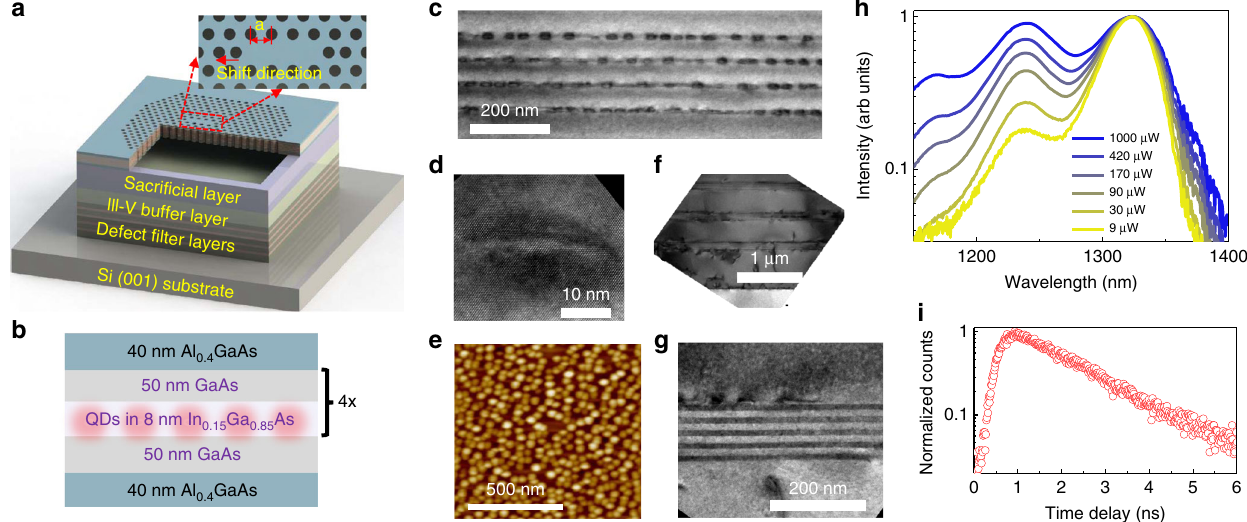
Fig. 1 Epitaxial growth, structural and optical characterisation. a Schematic diagram of the fabricated InAs/GaAs QD PC ( L 3 cavity) laser epitaxially grown on on-axis Si (001) substrate. The lattice constant, radius and shift of L 3 PC cavity are a , r and 0.15 a , respectively. b Schematic epitaxial structure of active region for the PC laser. c and d show the high-resolution cross-sectional bright- fi eld STEM images of the four-stack InAs QD layers and a single QD, respectively. e demonstrates an AFM image of uncapped InAs/GaAs QDs grown on Si (001) substrate. f presents a bright- fi eld STEM image of the interface between defect fi lter layers and on-axis Si (001) substrate. g shows the high-resolution TEM image of a defect fi lter layers. h Logarithmic plot of the normalised collected PL spectra under various input power at room temperature. i Time resolved PL measurement of the as-grown structure at room temperature, indicating a radiative recombination lifetime around 1.58 ns.